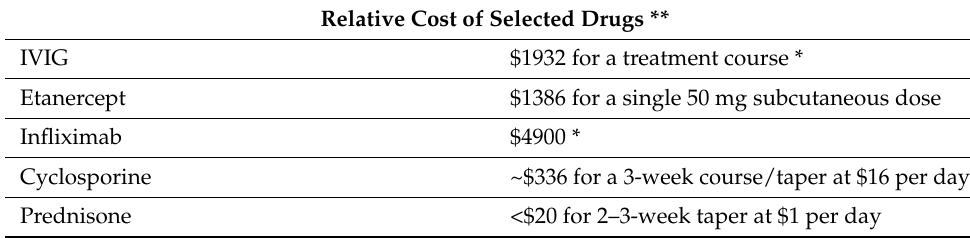
Table 9. Relative cost of selected drugs at a single academic center